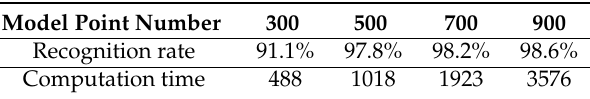
Table 3. Recognition rate and computation time (ms/scene) against model point number on the ACCV